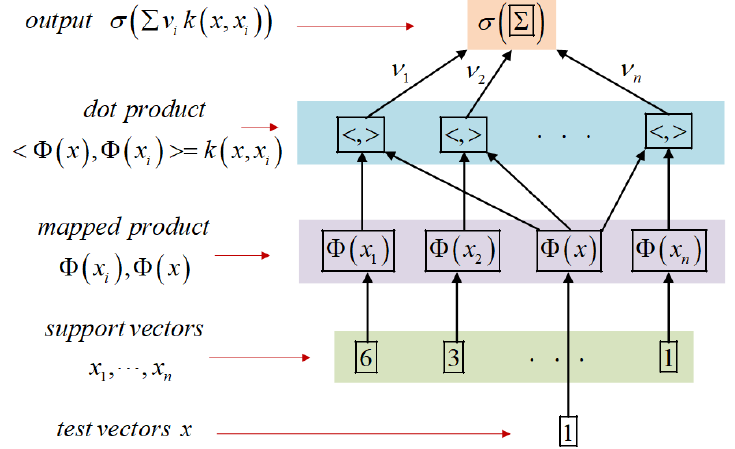
Figure 4. SVM classification module.